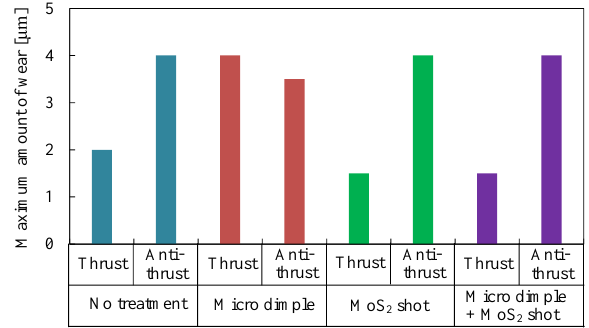
Fig. 11. FMEP at 40°C